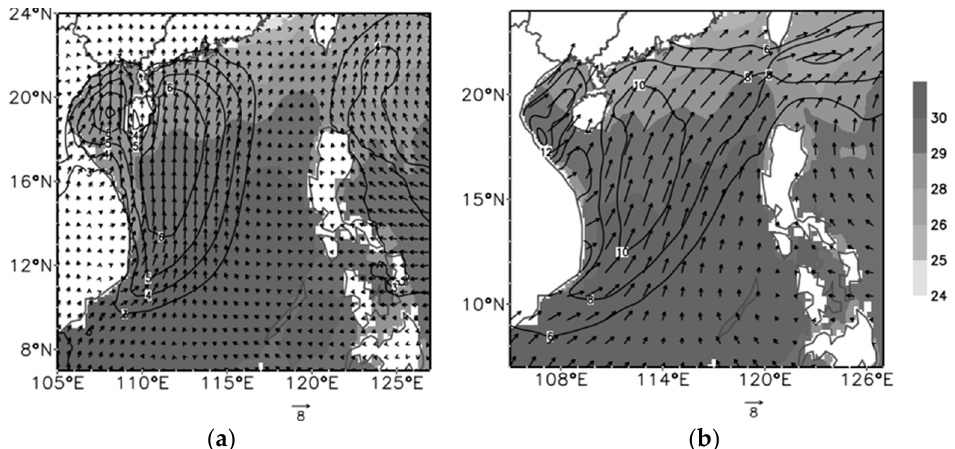
Figure 12. ( a ) ERA interim fields of the synoptic monthly means of the sea surface temperature (shaded, °C), 10 m wind speed (contour, ms − 1 ), and wind barbs of May 2015. ( b ) ERA interim daily fields at 0000 UTC in late May (from 20 May to 30 May) of the sea surface temperature (shaded, °C), horizontal wind speed (contour, ms − 1 ), and wind barbs at 950 hPa.